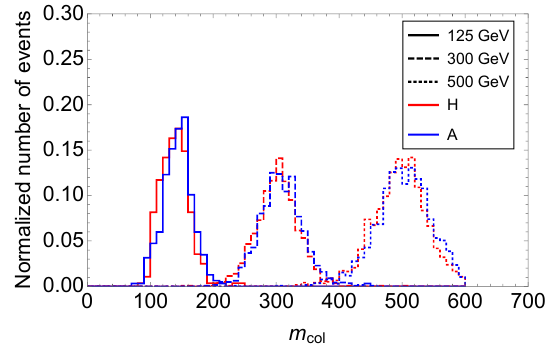
Figure 12. m col distributions for the scalar (red) and the pseudoscalar (blue) with m and 500